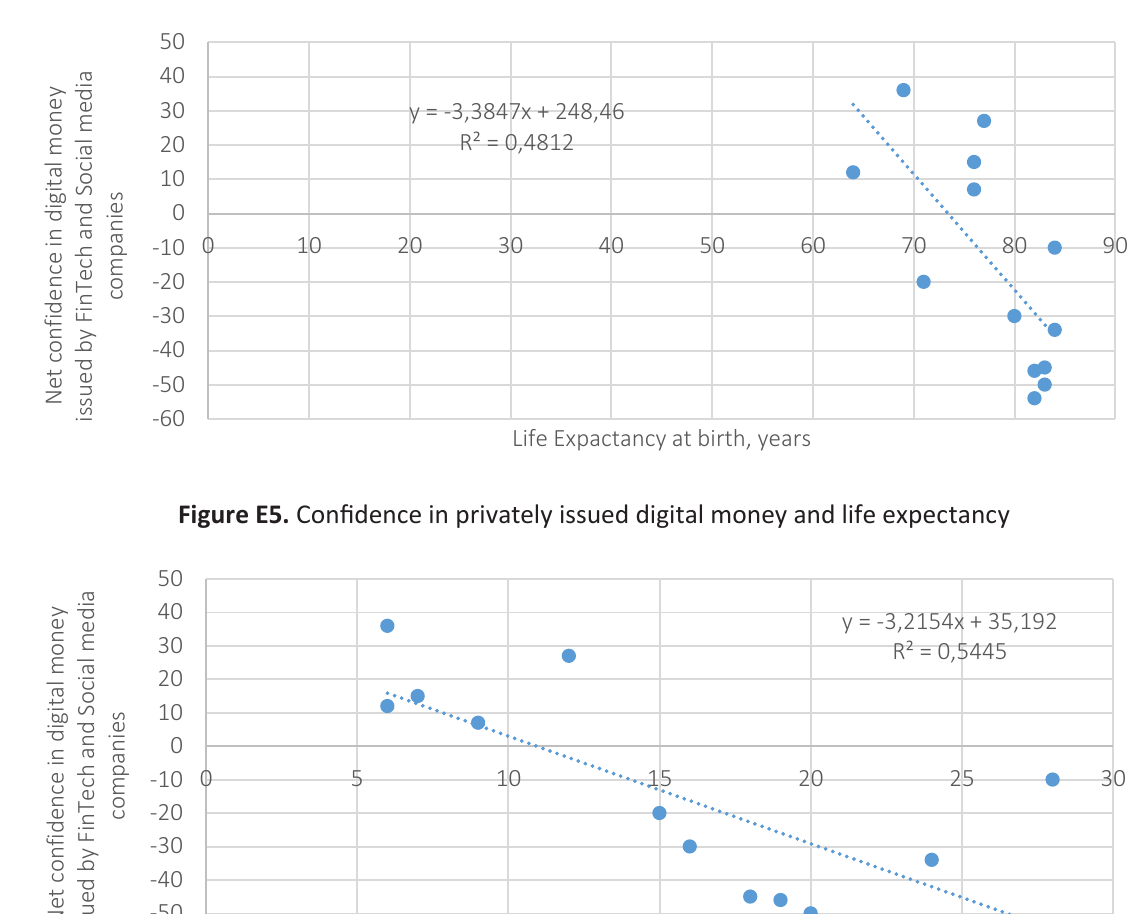
Figure E4. Confidence in privately issued digital money and the fraction of younger generation